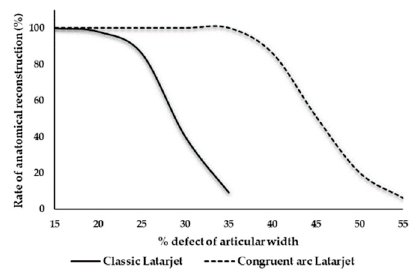
Figure 4. Relation between the anatomical reconstruction and defect size of the glenoid cavity for Classic Latarjet grafts and Congruent arc Latarjet grafts .